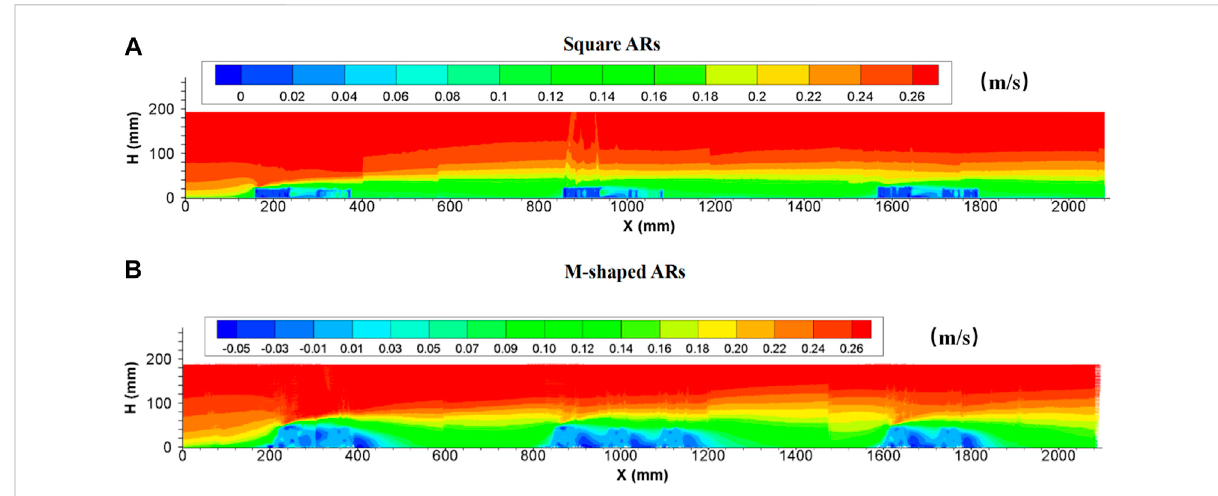
FIGURE 5 Side view of longitudinal velocity fi eld due to the presence of (A) square ARs and (B) M-shaped ARs under the same experimental